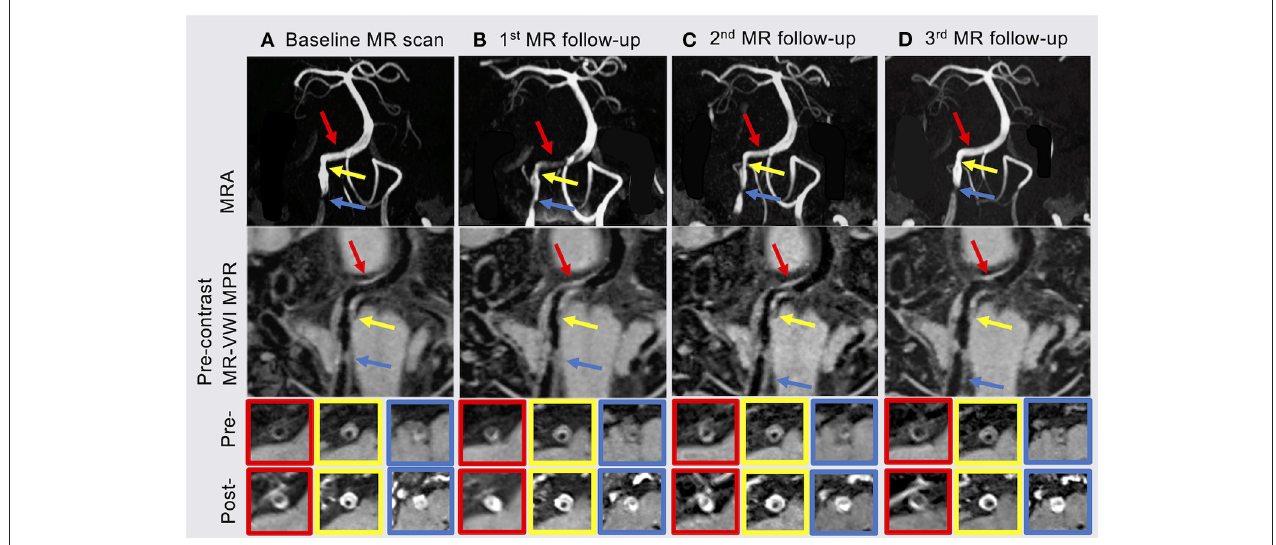
FIGURE 1 | (A) Baseline MR scan showed two plaques in the proximal (blue arrow) and middle (yellow arrow) of the right vertebral artery (VA) V4 segment. (B) The patient underwent the 1st MR follow-up scan 3 months after index stroke. MRA and MR-VWI showed a new plaque (red arrow) in the distal right VA V4 segment with severe stenosis and high enhancement ratio (ER). (C) Most of plaque features showed slightly regression at the 2nd follow-up MR scan 6 months after index stroke. (D) The 3rd follow-up MR scan 12 months after index stroke showed that the degree of stenosis, plaque-wall contrast ratio (CR) and ER of the plaque in the distal right VA V4 segment were back to baseline and slightly improved in the other two plaques. MRA, MR angiography; MR-VWI, MR vessel wall imaging; MPR, multiplanar reconstruction; Pre-, pre-contrast MR-VWI; Post-, post-contrast